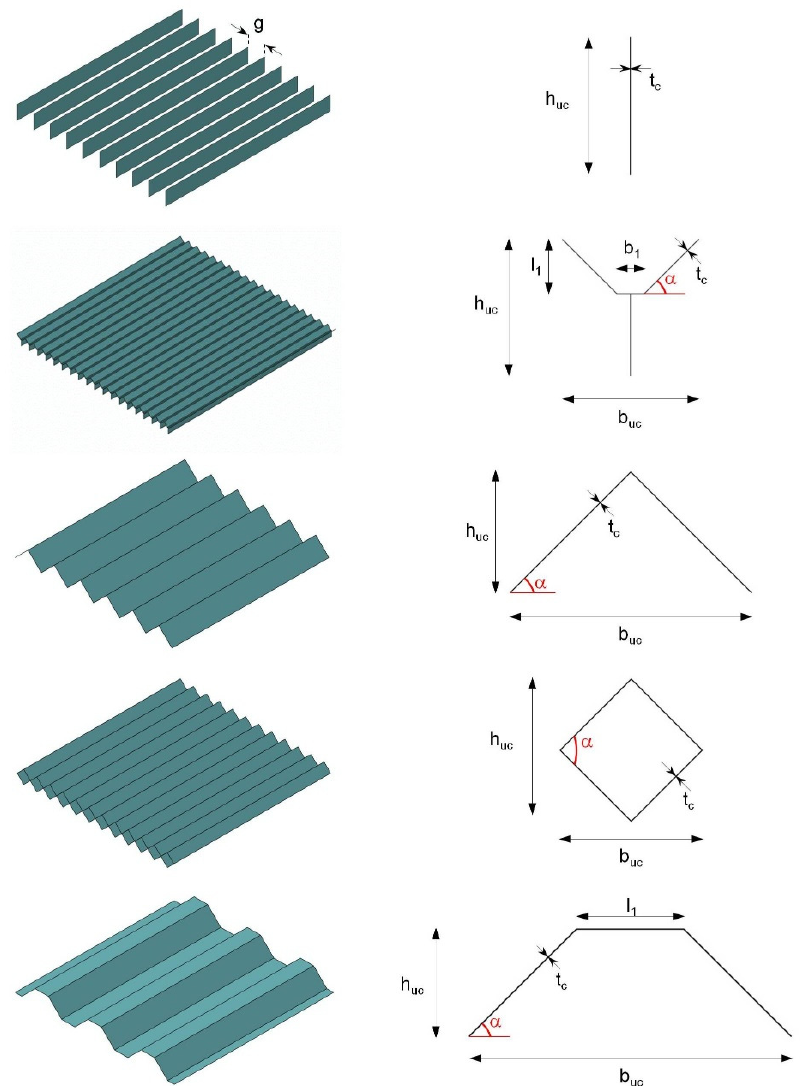
Figure 4. Sections of conventional prismatic open-cell cores with their respective unit cells (one layer, 1L). From top to bottom: I, Y, triangle, diamond, and container truss core.